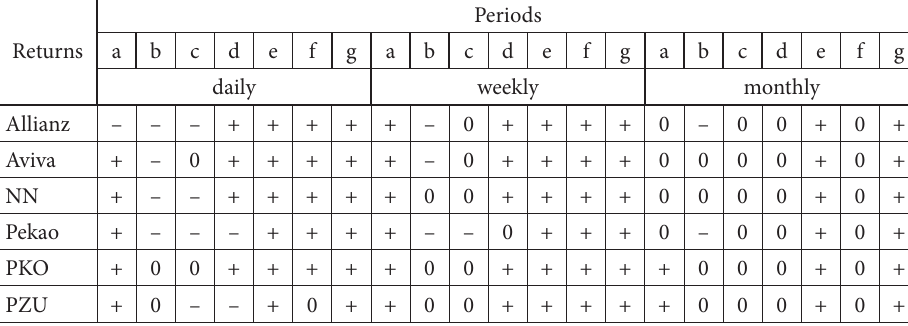
Note: positive values of statistics denote that returns from OFEs are bigger than from FIOs. Table 8. Decisions based on statistics (3) for the risk comparison of OFE and FIO; H 0 : D 2 (R OFE ) = D 2 (R FIO ) (source: own calculations)